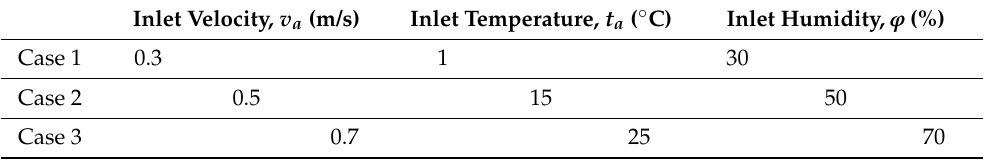
Table 6. Initial boundary conditions for numerical